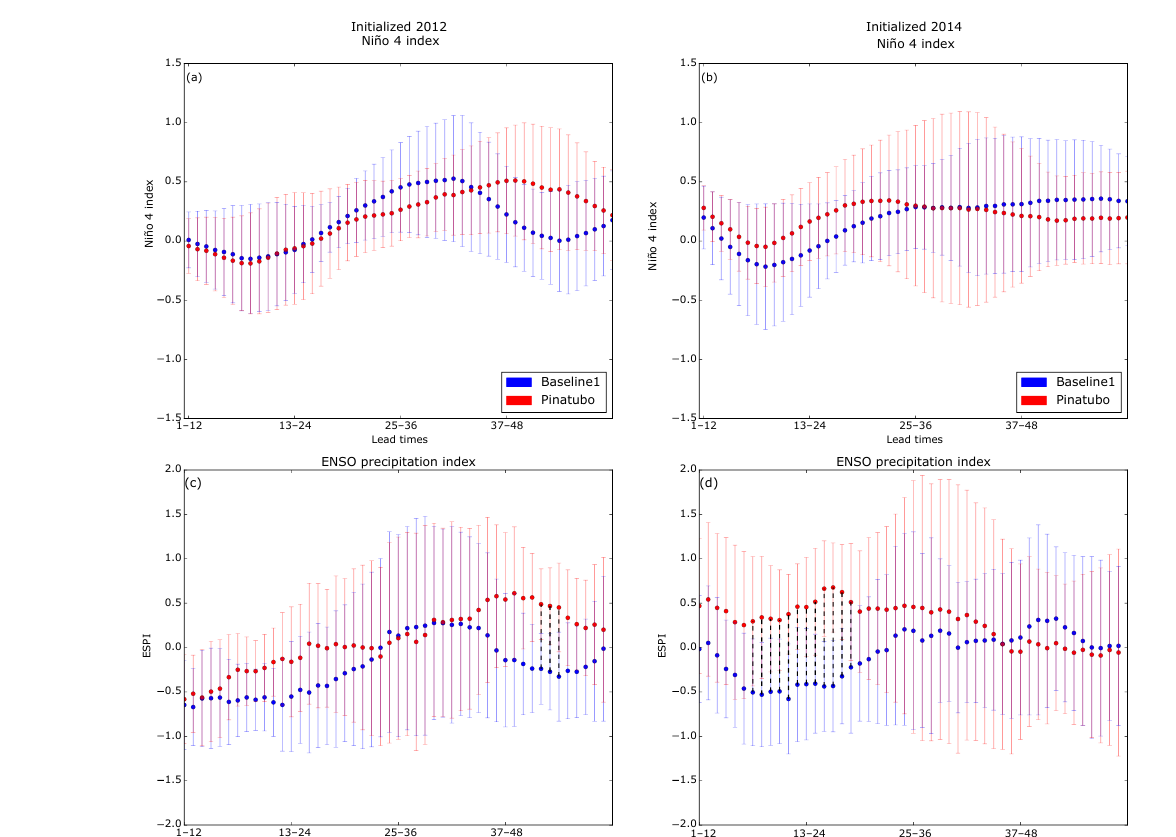
Figure 10. Top row shows the Niño 4 index and bottom row shows the ENSO precipitation index (ESPI) for the first four prediction years calculated as a 12-month running mean to reduce variance. Left (right) column shows the 2012 (2014) initialized experiments. Error bars show the SD of the ensemble and vertical black lines indicate a significant